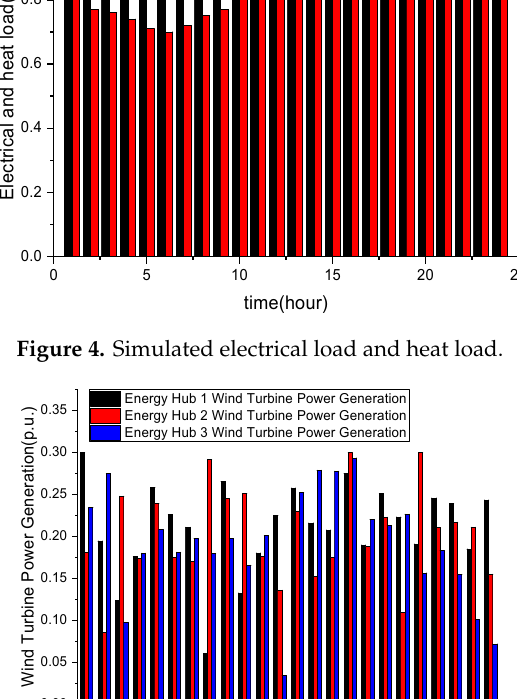
Table 2. Assumed energy prices.